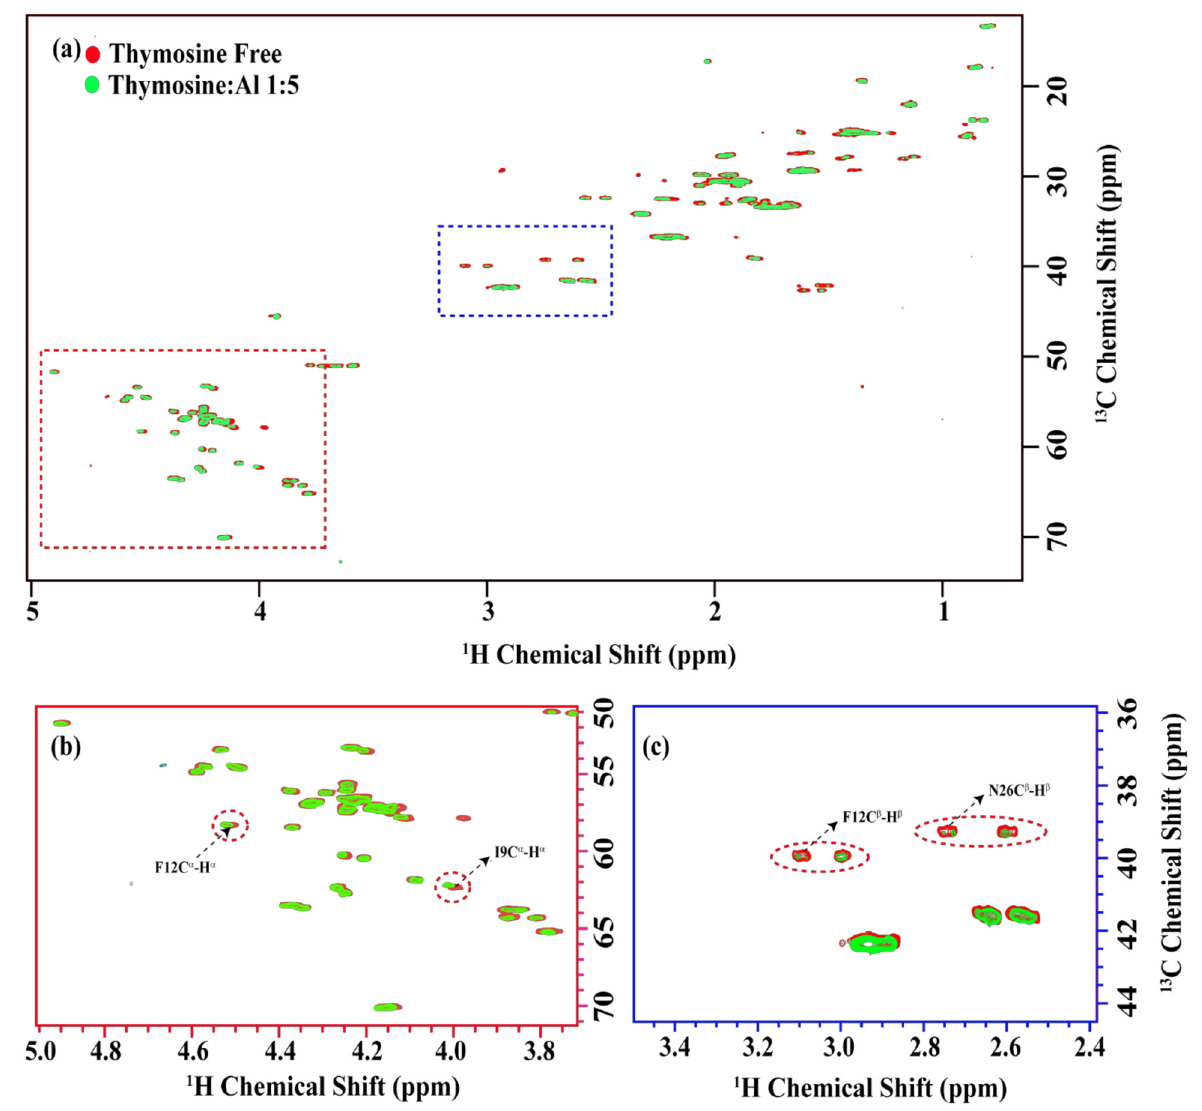
Figure 1. ( a ) The overlay of the two-dimensional 13 C- 1 H HSQC spectra in free form (red) and with thymosin: Al 3+ ratio 1:5 (green). The alpha and beta proton regions are highlighted in the red and blue dotted rectangles in ( a ) and are presented in ( b , c ), respectively. Noticeable chemical shift changes were observed for F12, I9 as indicated by red circles in ( b ). Otherwise, the chemical shifts remain the same, with only some decrease in the intensities, as highlighted by the red circles in ( c